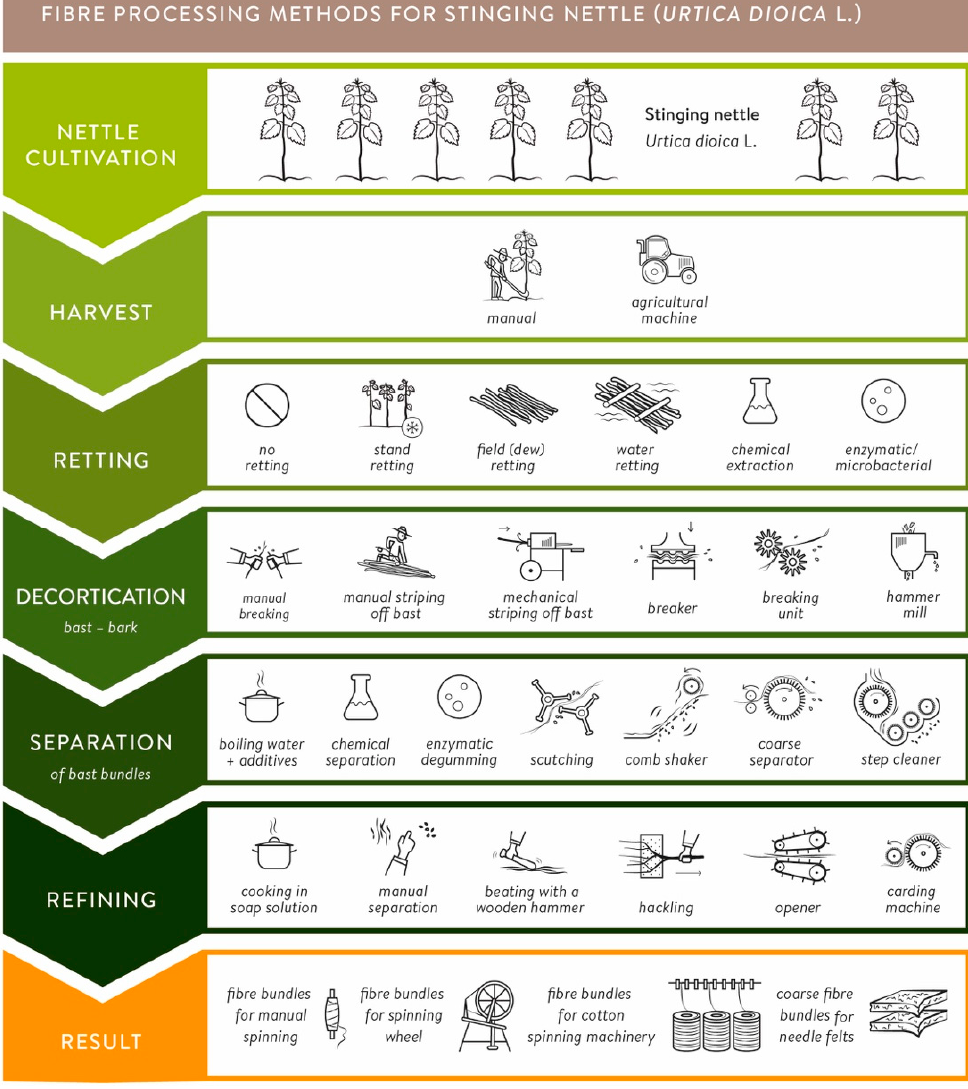
Figure 8. Bast fiber extraction and separation methods for nettle plants (compilation of techniques that graphically illustrate the methods described in the text).